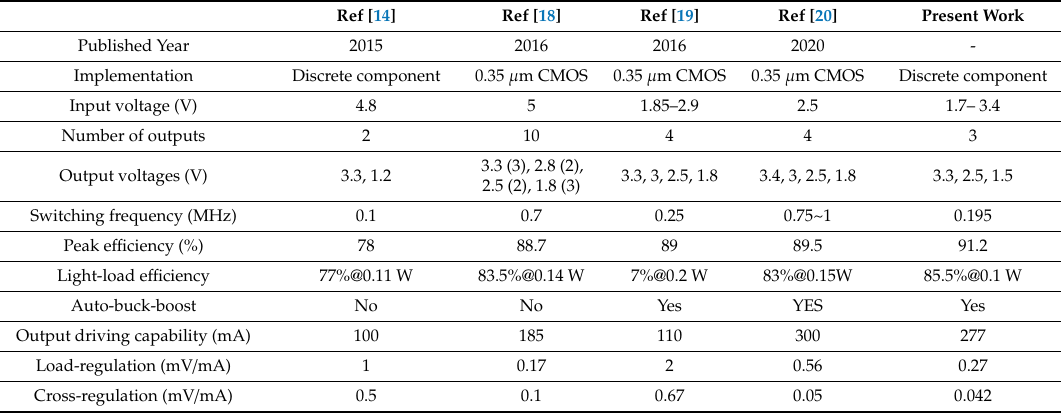
Table 3. Comparison of performance with previous